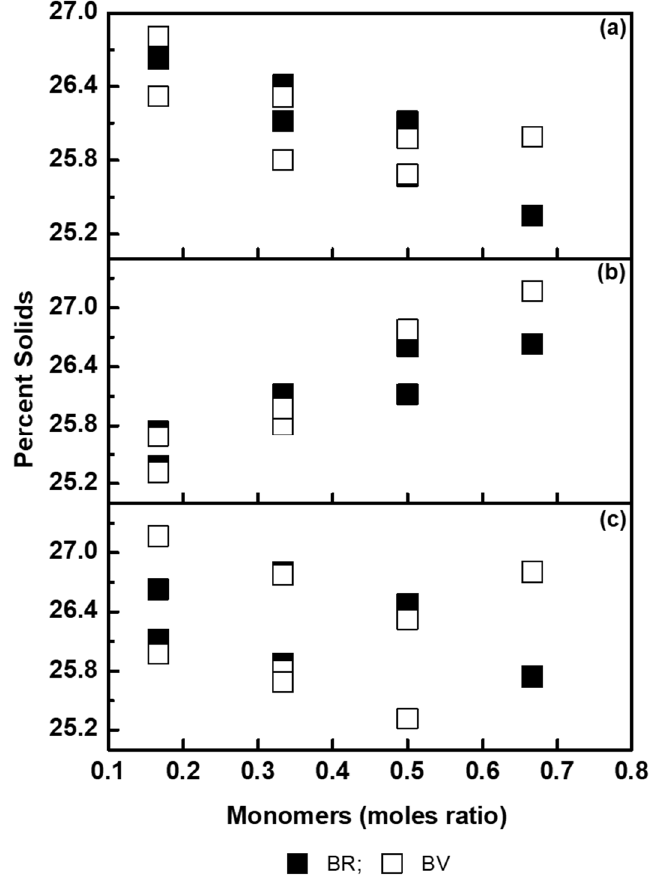
Figure 4. Percent solids of fluorescent dispersions formed during microemulsion polymerization as a function of moles ratio of ( a ) BZMA, ( b ) MMA and ( c ) HPMA.